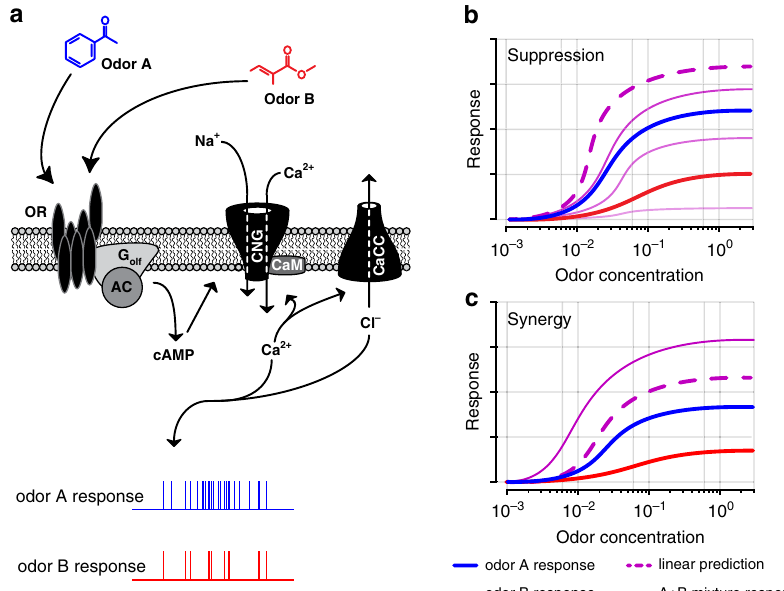
Fig. 1 Schematic of signal transduction and nonlinear odor mixture interactions in OSNs. a Schematic of sensory transduction in OSNs. Odors generate responses in OSNs with different levels of ef fi cacy. Olfactory receptor (OR), adenylyl cyclase (AC), cyclic nucleotide gated channel (CNG), calmodulin (CaM), calcium-activated-chloride channel (CaCC). b Mixtures of odors can give rise to nonlinear responses in OSNs. Three solid purple lines show hypothetical mixture suppression (antagonism) at varying levels with respect to the component-based linear prediction (dashed purple). c Although less common, mixture responses can also display synergy where the mixture response exceeds the component-based linear